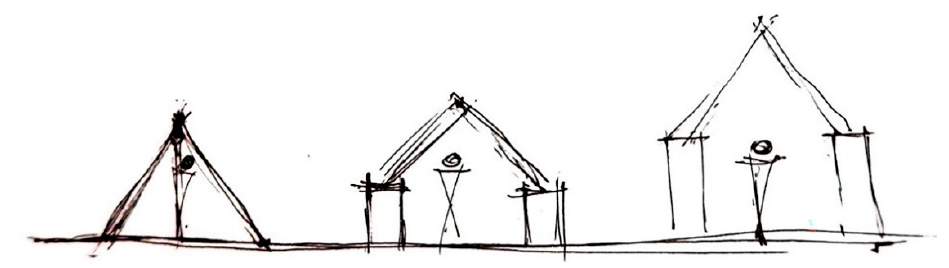
Figure 9. Development of cabin, sketch: A. Kapetanovi ć .